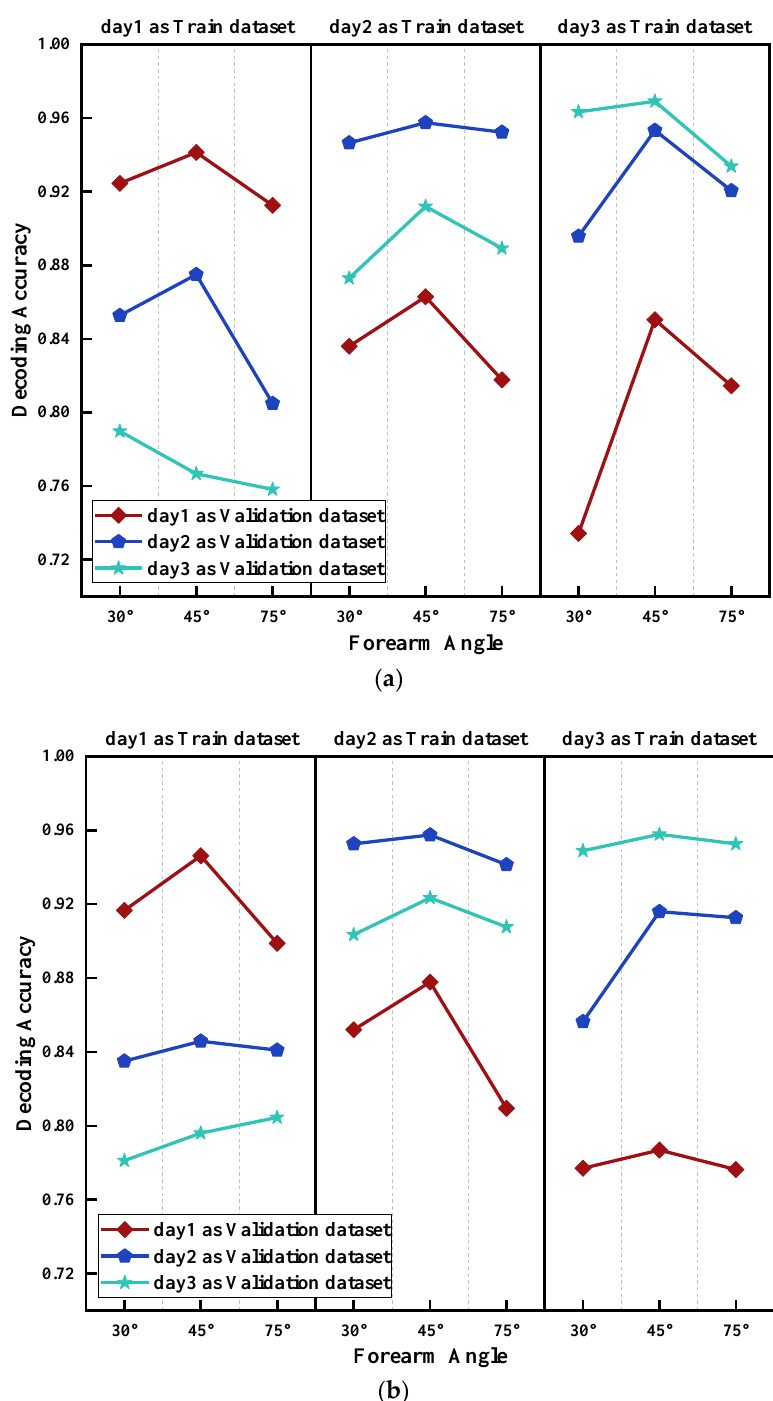
Figure 11. Influence of acquisition time on the accuracy of gesture decoding; day1 as Validation dataset, day2 as Validation dataset and day3 as Validation dataset means using Class day1 , day2 and day3 to test trained model, respectively. ( a ) Influence of acquisition time using LDA; ( b ) Influence of acquisition time using PNN.